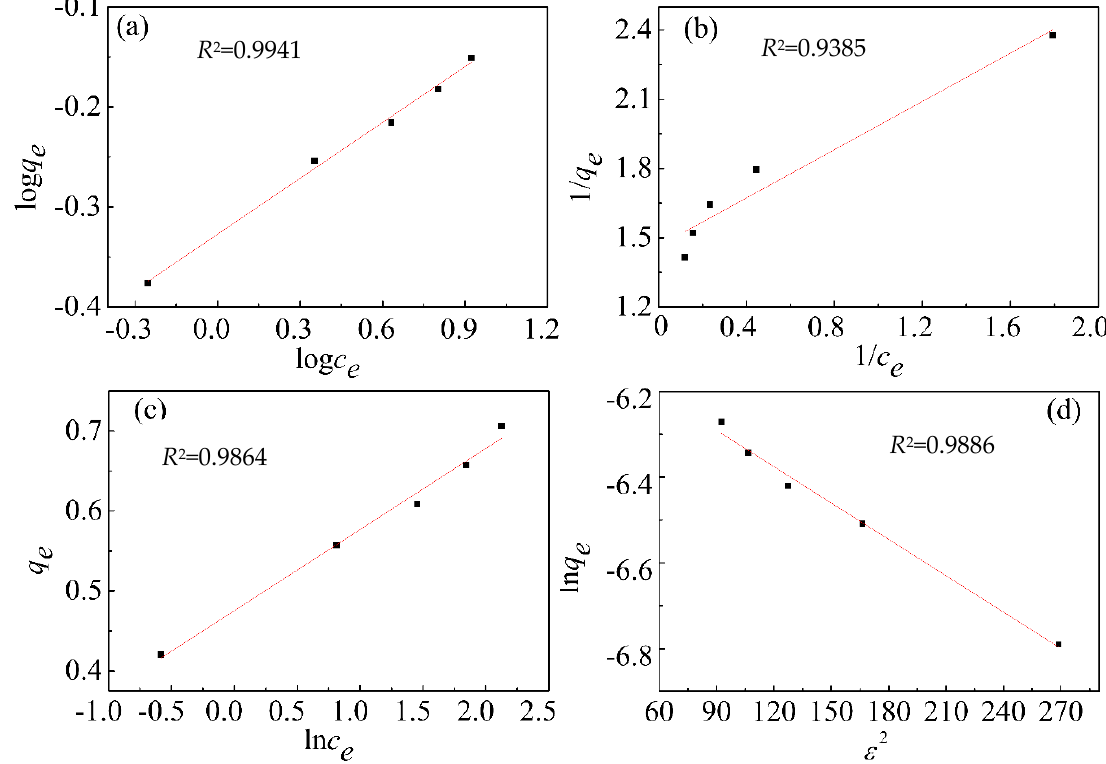
Figure 3. The adsorption data of methylene blue dye on bone char fitted with ( a ) Freundlich, ( b ) Langmuir, ( c ) Temkin, and ( d ) DKR isotherm models (particle size: 0.50~0.80 mm, T : 303 K, t : 15.5 h).